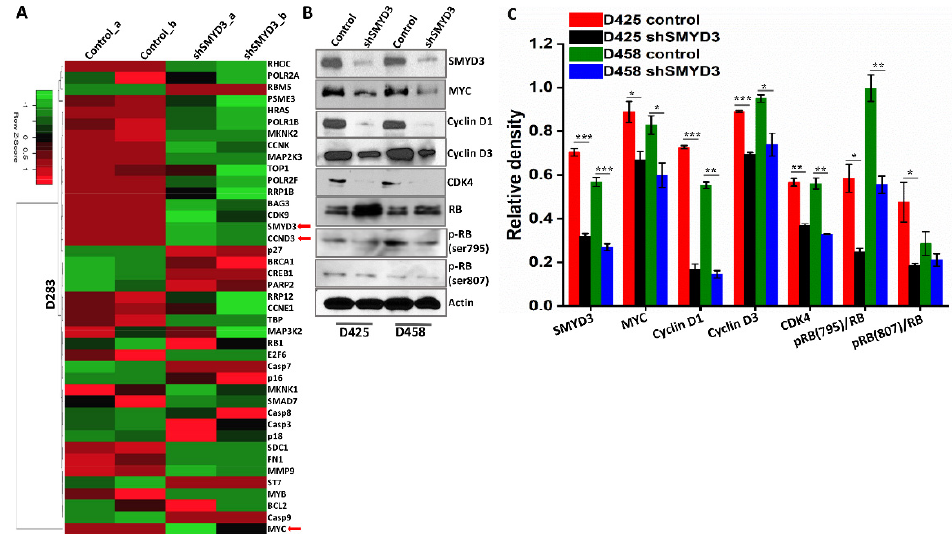
Figure 6. SMYD3 knockdown affects cell cycle molecules . ( A ) Heat map showing differentially expressed genes in D283 control vs. shSMYD3 transfected cells (48 h) in duplicates; upregulated genes are shown in red, downregulated genes are shown in green. ( B ) Protein expression and densitometric analysis of SMYD3, Myc, cyclin D1, cyclin D3, and CDK4 in the control and shSMYD3 treated D425 and D458 cells (48 h); actin was used as a loading control. ( C ) Graph depicting the densitometry analysis for the proteins in the western blot in MB cells. The ratio of the relative level of phosphorylated ( p ) RB to total RB is plotted for each experimental condition. The statistical significance * p < 0.05, ** p < 0.01, *** p < 0.001.